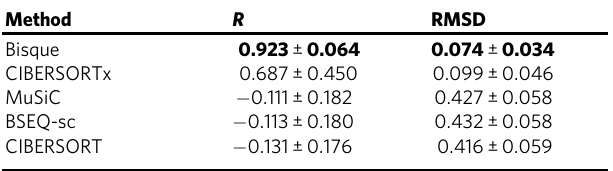
Proportions based on snRNA-seq were used as a proxy for the true proportions. Performance measured in Pearson correlation ( R ) and root-mean-square deviation (RMSD) across all 5 identi fi ed cell types in each sample. Reported values were averaged across the 6 samples with standarddeviationindicated.Boldvaluesindicatethehighestperformingmethodwithrespectto each metric. Source data are provided as a Source Data fi